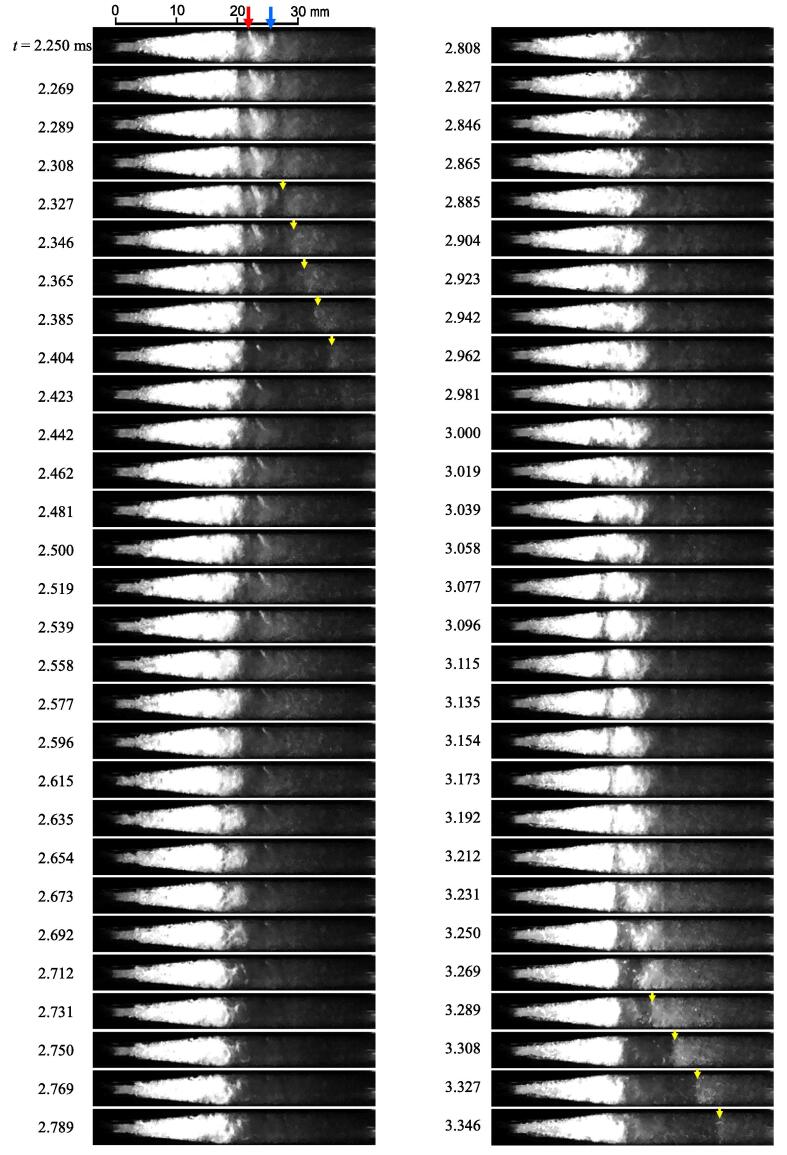
Unsteady behavior of vortex cavitation (p1 = 0.6 MPa, p2 = 0.1 MPa, t = 2.250 – 3.346 ms).